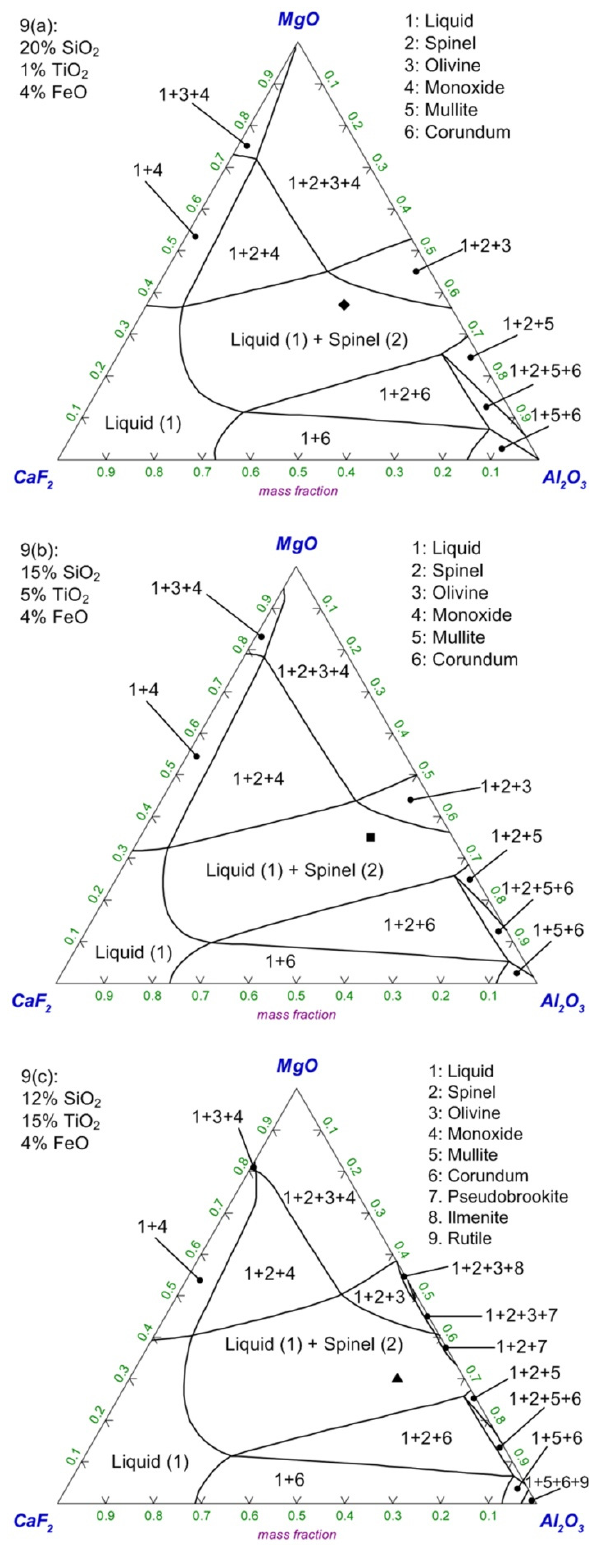
Figure 9. ( a – c ) CaF 2 -SiO 2 -Al 2 O 3 -MgO-TiO 2 -FeO pseudo-ternary phase diagrams for 1400 °C, as calculated in FactSage 7.3